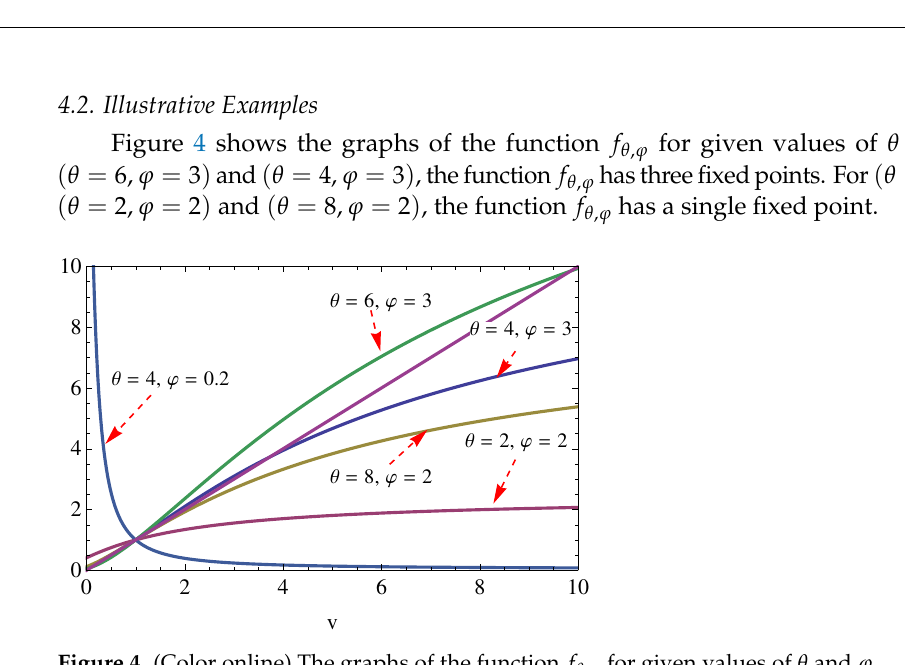
Figure 4. (Color online) The graphs of the function f θ , ϕ for given values of θ and ϕ . The graph of the function f θ , ϕ for ( θ = 0.2, ϕ = 0.3 ) is plotted in Figure 5. One can see that there are tree fixed points for ( θ = 0.2, ϕ = 0.3 ) .